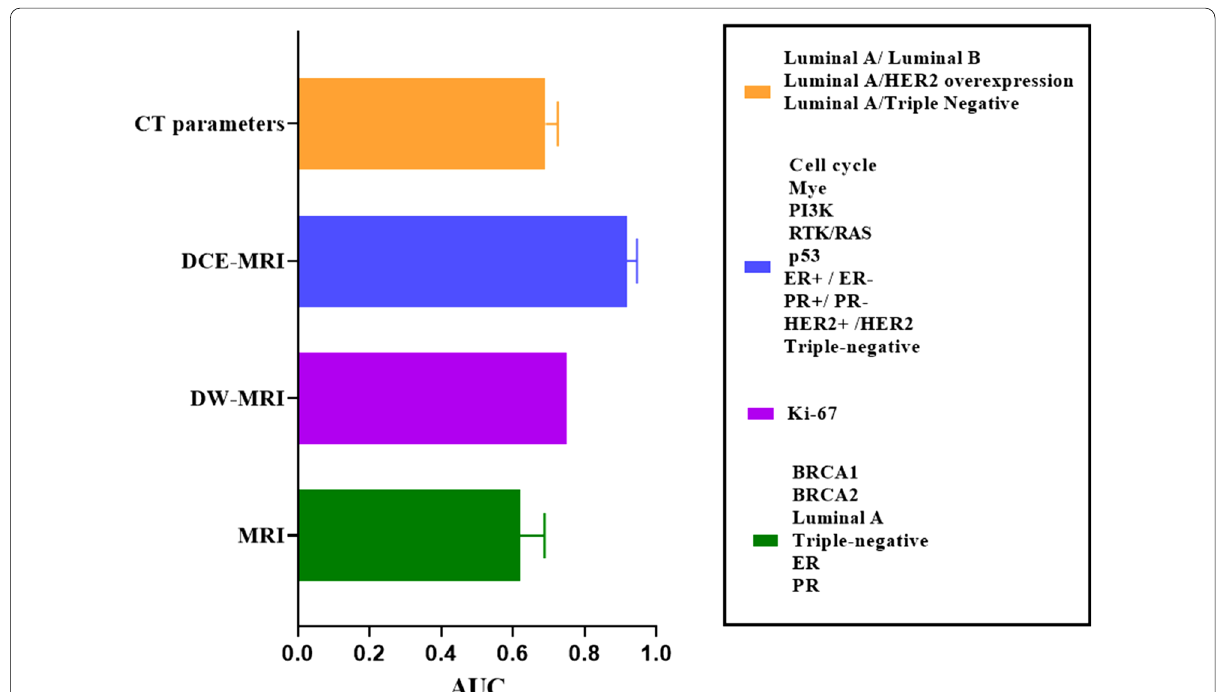
Fig. 3 Summary of area under the curve (AUC) values of various modalities to predict genomic indicators and molecular subtypes of breast cancer patients (11, 13–17). *Represent P value < 0.05 significant difference with other